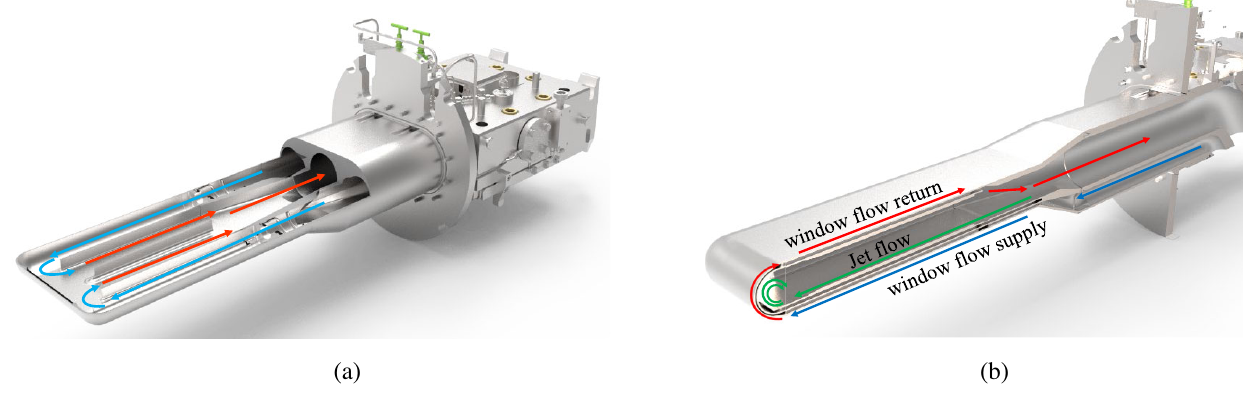
FIG. 2. Isometric cut view of target showing bulk flow (a) and elevation cut view of target showing window and jet flows